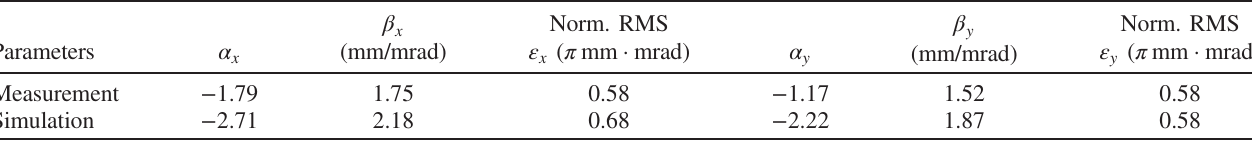
TABLE IV. Beam Twiss parameters at the exit of the IH-DTL.